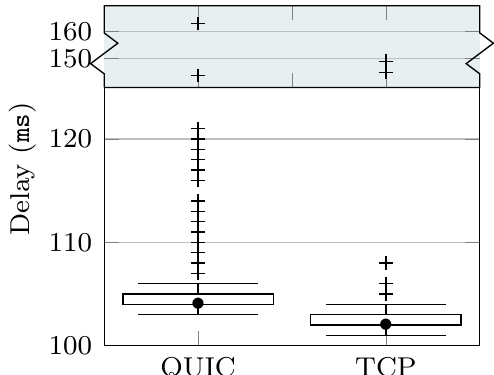
Figure 6. Boxplot of the delay experienced with QUIC and TCP over the cellular channel with ideal conditions ( P loss = 0). Ordinate axis is split to show the range of outliers, which are shown using a logarithmic